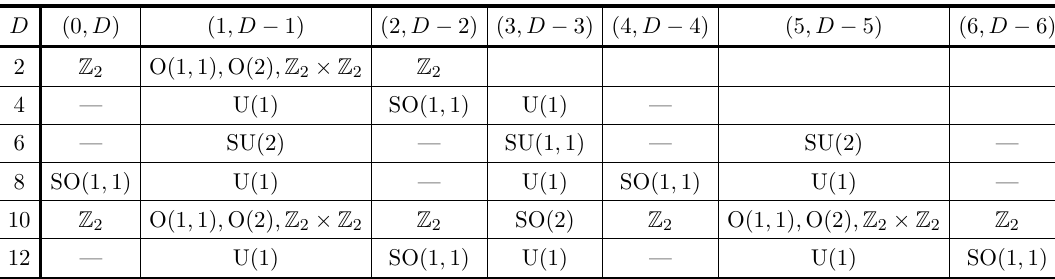
Table 8. R-symmetry groups for N = 1 and ( N + , N − ) = (2 , 0) , (1 , 1) , (0 , 1) supersymmetry algebras with d real supercharges in even dimensions. A dash indicates signatures where no such S supersymmetry algebra